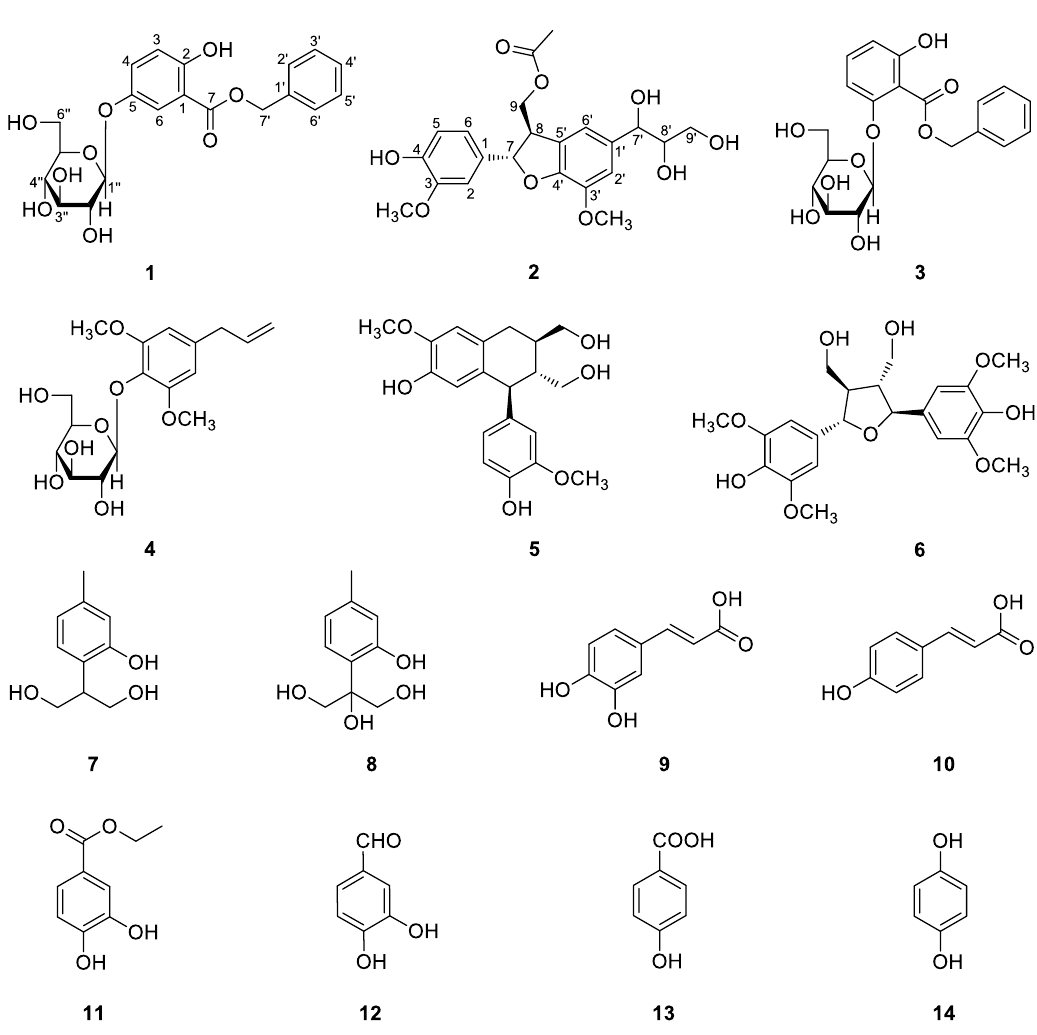
Figure 1. Chemical structures of compounds 1 − 14 .